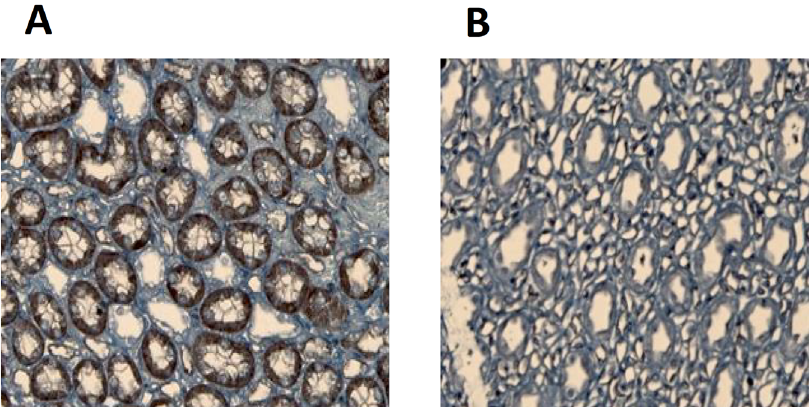
Fig. 5 The pre-hyperammonemic diet affected the expression of transporters. Immunohistochemistry showing overexpression of NKCC2 in the HD ( A ) vs AL ( B )